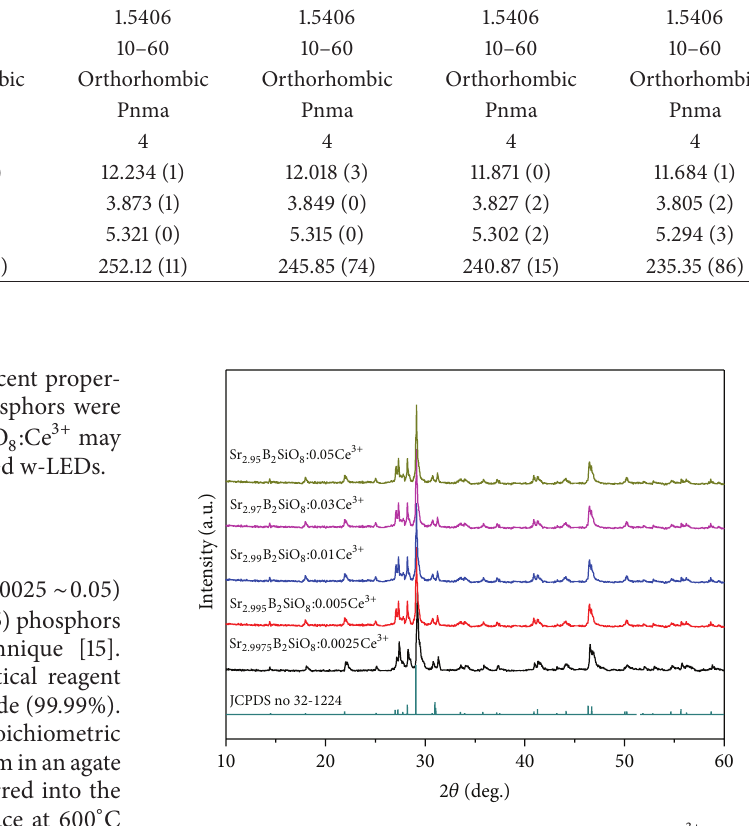
different Ce 3+ concentrations are shown in Figure 1. All of the diffraction peaks are in accordance with Sr 3 B 2 SiO 8 (JCPDS card number 32-1224). All these samples are single phase without any impurities. This indicates that doping Ce 3+ ions in Sr 3 B 2 SiO 8 host with such a small concentration has no other phase specific changes. The crystal system is Orthorhombic, the space group is Pnma, and lattice parameters of a = 12.355 (2), b = 3.916 (1), c = 5.405 (4), and V = 261.50 (56) ˚A 3 . When the replacement of Sr 2+